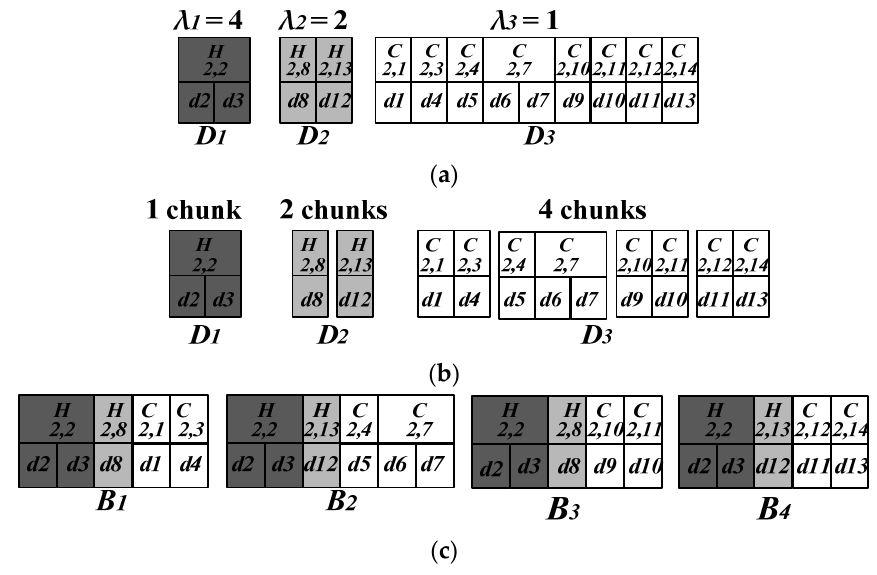
Figure 3. Applying BD to generate a non-flat broadcast program: ( a ) grouping cells into disks; ( b ) splitting disks into chunks; ( c ) interleaving chunks to form a broadcast cycle.